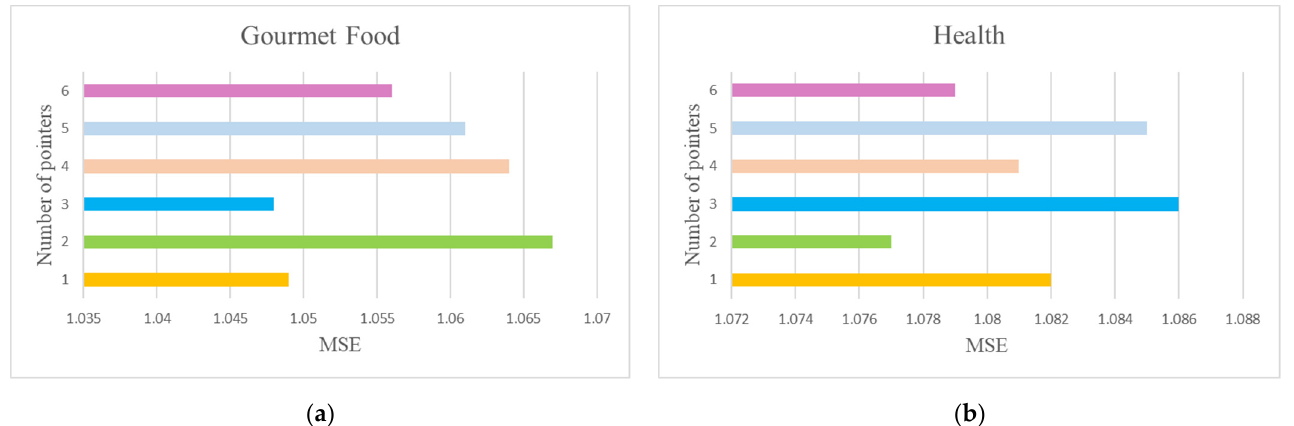
Figure 5. ( a ) Effect of number of pointers on the performance of MPCAR model (Gourmet Food); ( b ) Effect of number of pointers on the performance of MPCAR model (Health). ( b ) Effect of number of pointers on the performance of MPCAR model